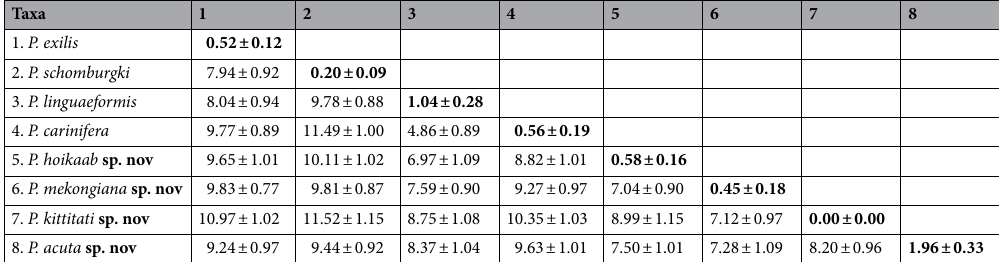
Table 1. Average interspecific genetic divergence (uncorrected p-distance: % ± S.E.) between Pilsbryoconcha species (below diagonal) calculated from the 660 bp COI gene fragment sequences. Average intraspecific distances within each species are shown in bold.